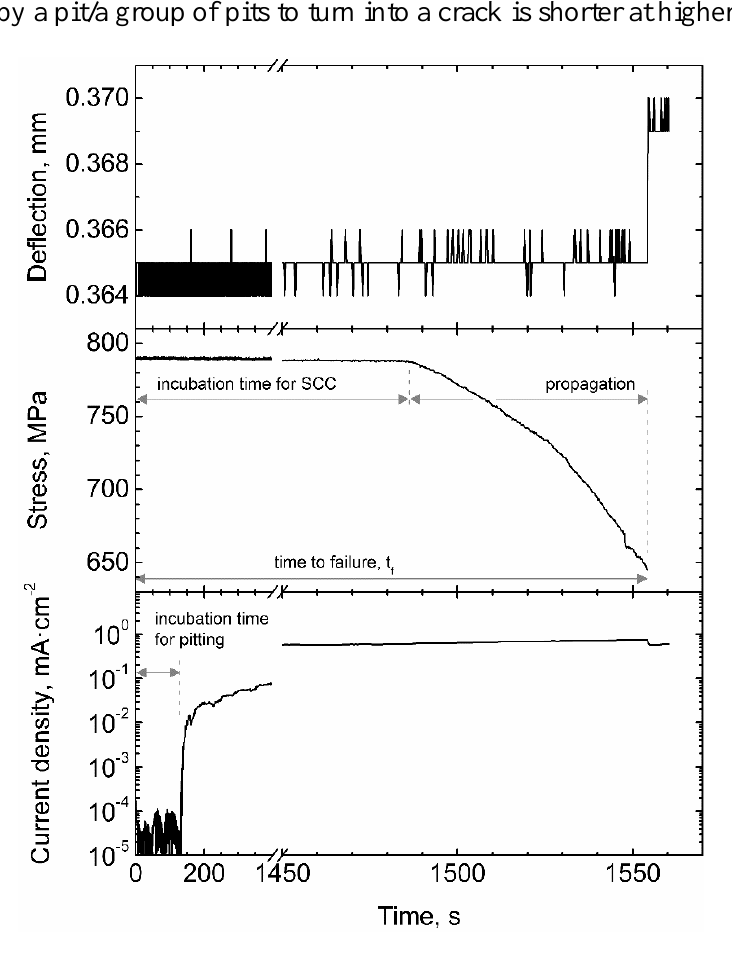
Figure 4. The evolution of deflection, stress, and current density of a bulk glass forming Zr 52.5 Cu 17.9 Al 10 Ni 14.6 Ti 5 alloy (Vitreloy 105) sample in 0.01 M Na 2 SO 4 + 0.01 M NaCl solution under three-point bending at an initial stress of 30% of the yield strength at 0.2% offset, and an applied anodic potential of 50 mV vs.